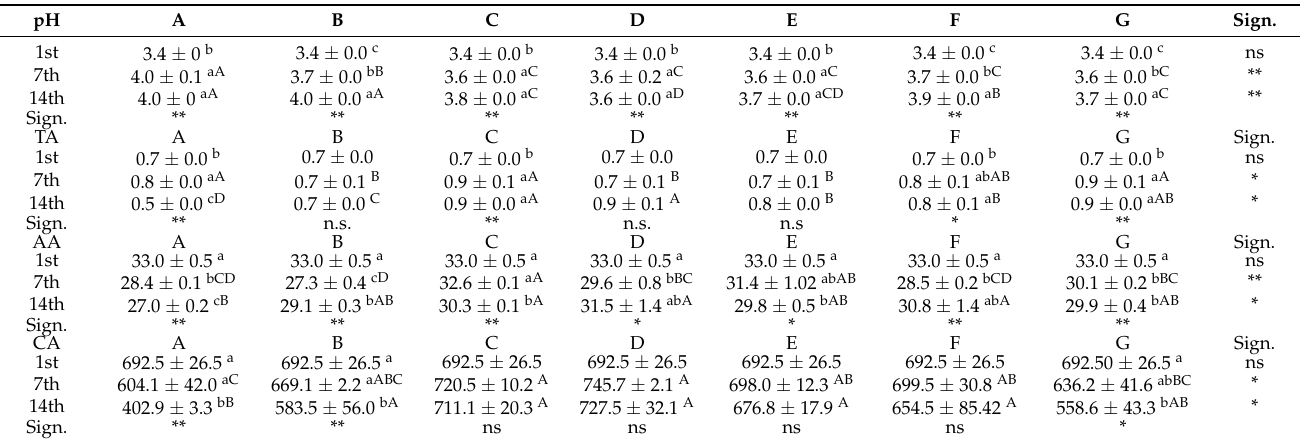
Table 7. The pH, TA (% citric acid), and organic acid contents (ascorbic acid, AA; mg 100 g − 1 ; citric acid, CA; mg 100 g − 1 ) of